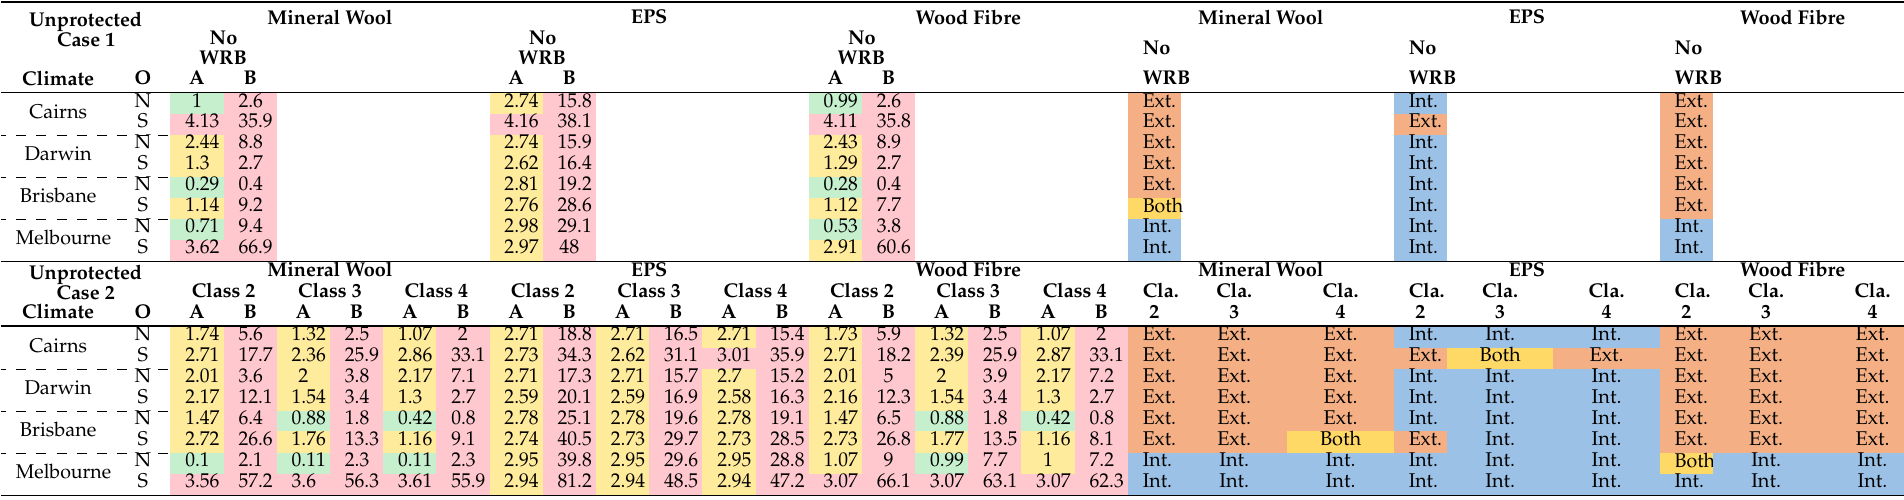
Table A6. Unprotected CLT results for internal insulation. O (orientation). Performance criteria: A (mould growth index), B (corrosion rate). Classification of WRB: Class 2, 3, and 4 (vapour permeance). Green (pass), red (fail), or yellow (further investigation). Critical surface that fails the performance criteria indicated in right table: Ext. (external surface), Int. (internal surface), Both (both